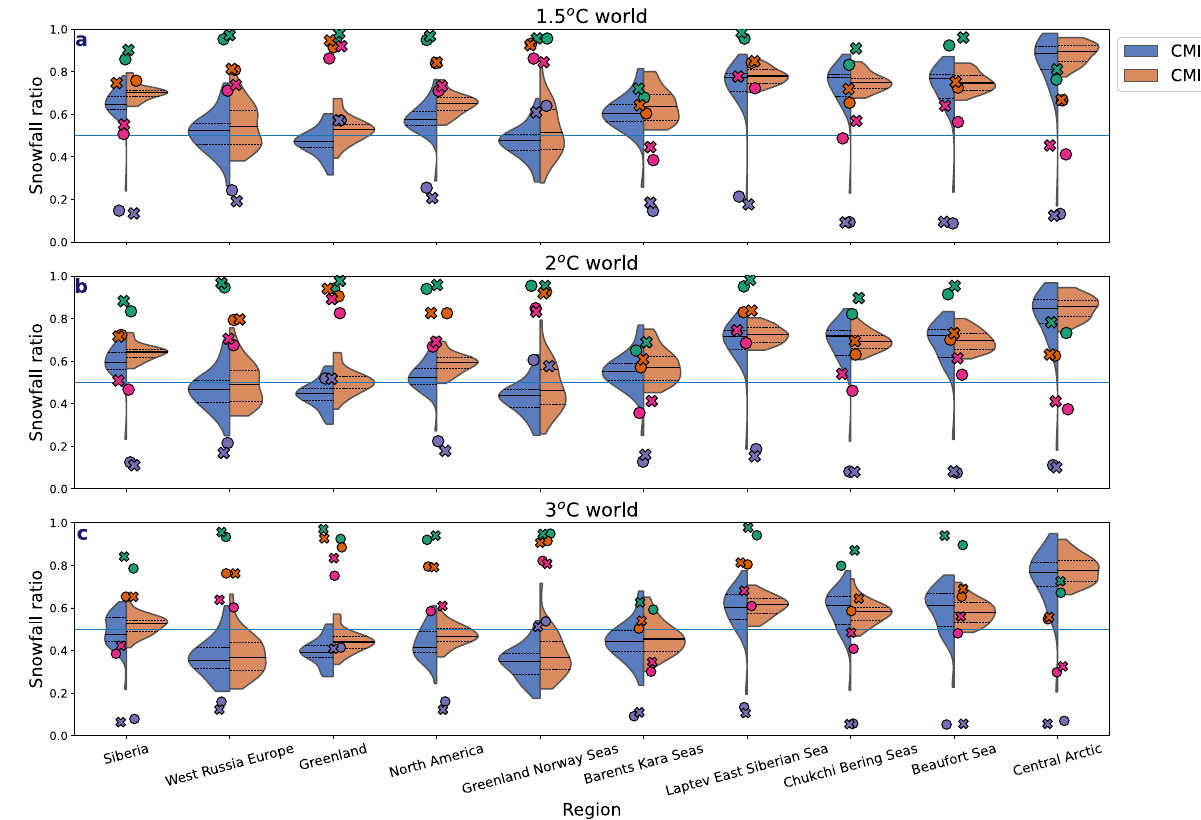
Fig. 10 Snowfall ratio per region in a 1.5 °C, 2 °C and 3 °C global warming scenarios. The snowfall ratio for different regions (identi fi ed in Supplementary Fig. 4) across the Arctic following 1.5 °C, 2 °C and 3 °C global warming for CMIP6 (blue) and CMIP5 (orange) with the dashed black lines showing the 25th – 75th and the solid black lines showing the multi-model mean. The solid blue line identi fi es when the snowfall ratio is at 0.5. The circles and x ’ s represent the multi-model ensemble mean snowfall ratio at 1.5 °C, 2 °C and 3 °C for CMIP6 (circles) and CMIP5 ( x ’ s) for December – February (green), March – May (orange), June – August (purple) and September – November